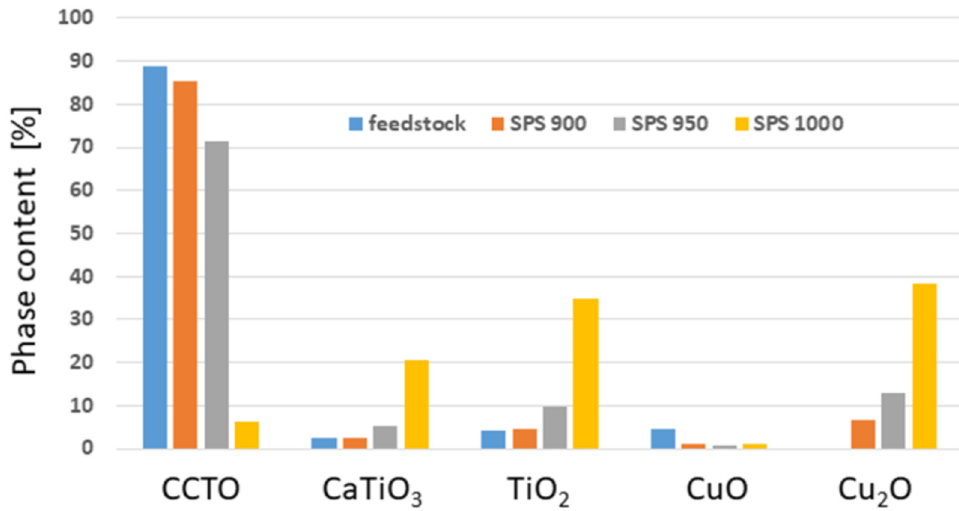
Figure 4. Phase content [%] in the SPS samples B, C, D (see Table 1) sintered at 900, 950, and 1000 °C from the P2 powder. Table 1. Sample labeling system.